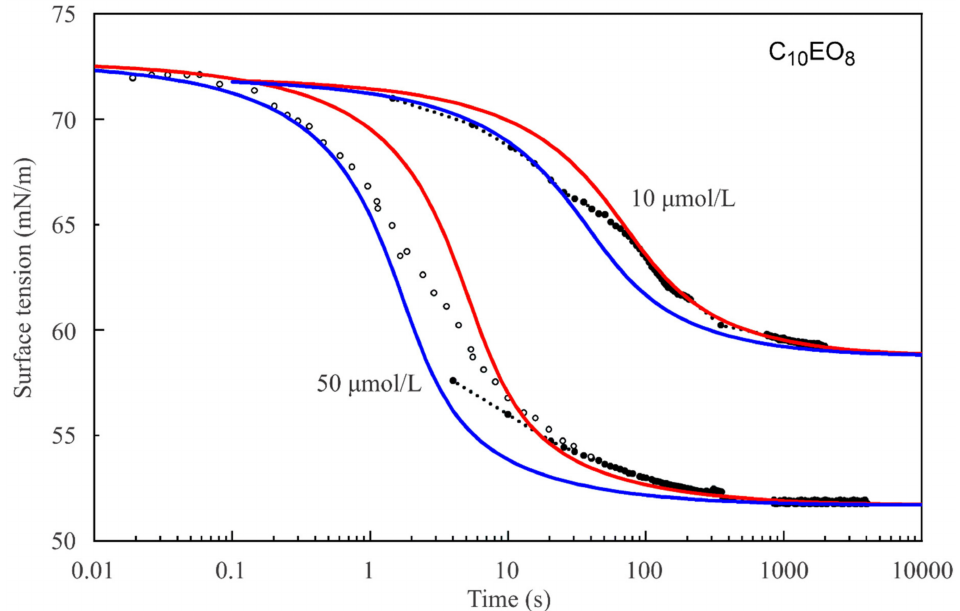
Figure 4. Experimental surface tensions as a function of time measured by PAT-2 (black symbols) and BPA-1 (open symbols) for C 10 EO 8 solutions with concentrations of 10 µ mol/L and 50 µ mol/L, respectively, and the corresponding theoretical curves calculated according to the reorientation model with different diffusion coefficients: 8 × 10 − 10 m 2 /s for 10 µ mol/L and 7.5 × 10 − 10 m 2 /s for 50 µ mol/L (blue lines), 4 × 10 − 10 m 2 /s for 10 µ mol/L and 2.5 × 10 − 10 m 2 /s for 50 µ mol/L (red